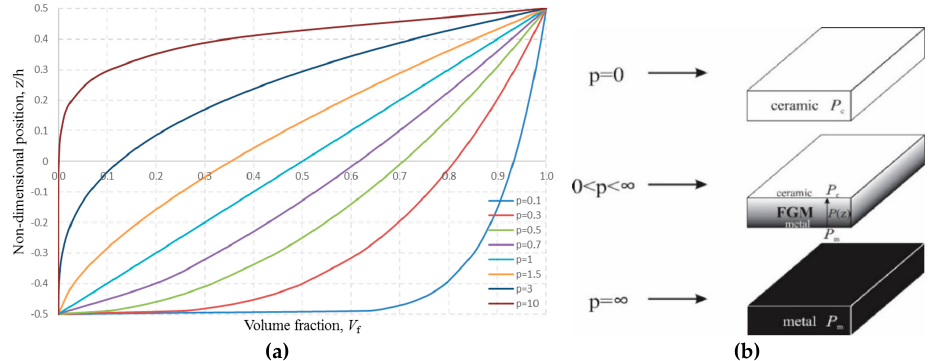
Figure 4. The comparison of homogenous plates (ceramic or metal) and FGM plates: ( a ) volume fraction of the material; ( b ) homogenous and FGM plates.